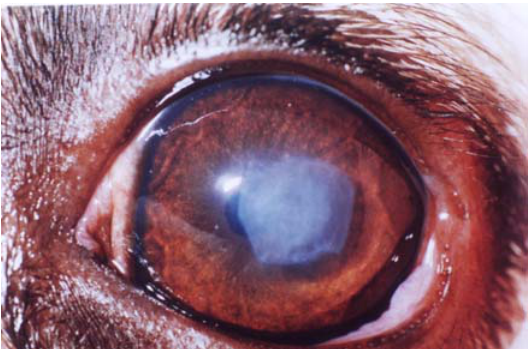
Figure 5. Detail of a dog cornea 15 days after application of the fibrin adhesive derived from snake venom in an animal of Group 4. There was total repair of the wound and complete filling of the keratectomized area with scar tissue.